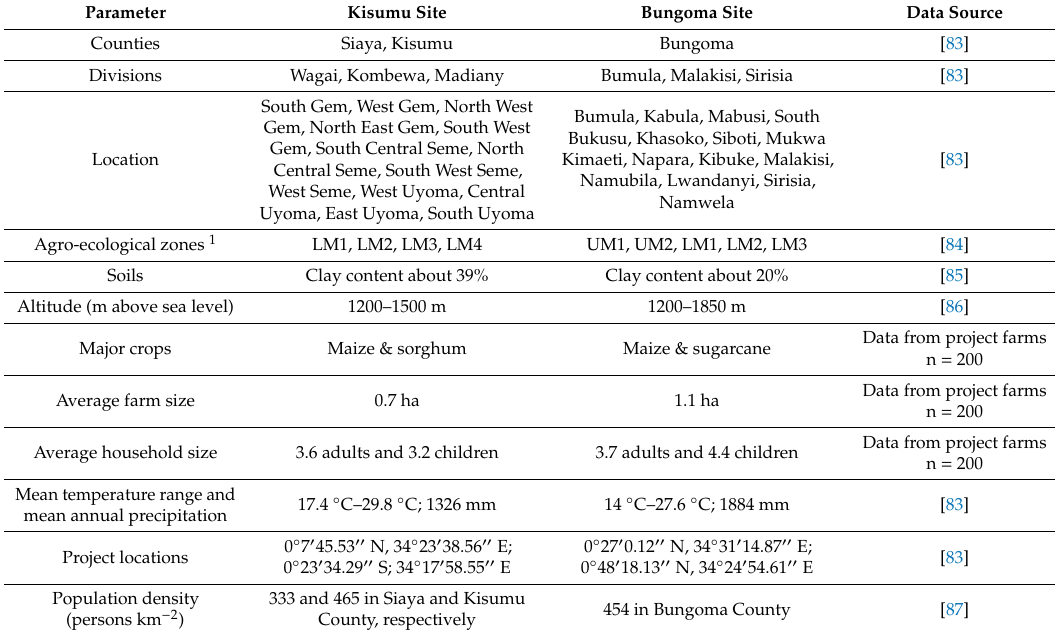
Table A2. Characteristics of the Kenya Agricultural Carbon Project (KACP) sites at Kisumu and